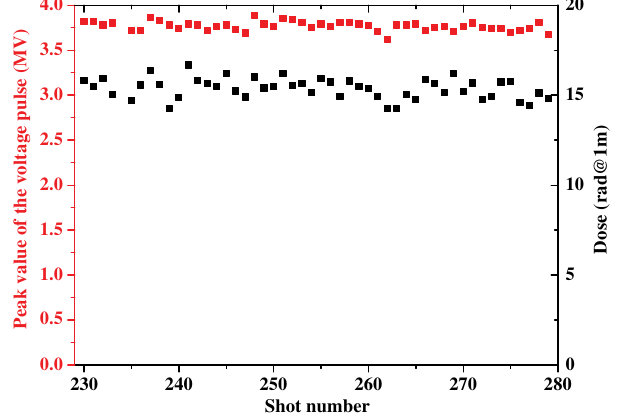
FIG. 16. Peak values of the voltage pulses downstream of the last cavity and the X-ray doses for 50 consecutive shots.